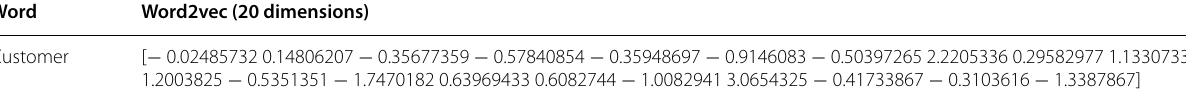
Table 5 The sample of